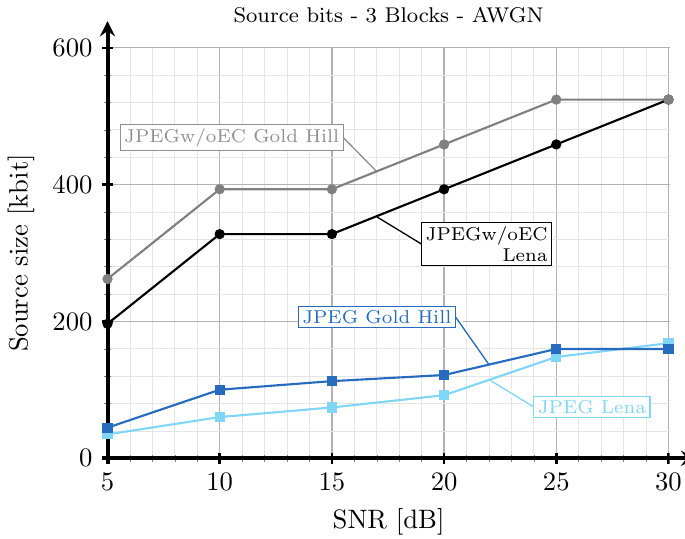
Figure 20. Source size vs. SNR for three blocks and AWGN